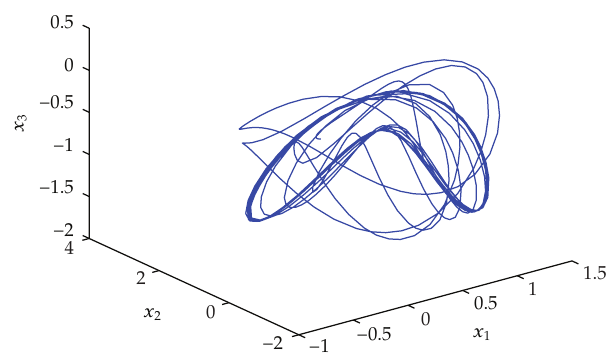
Figure 8: The created Hopf circle in Case